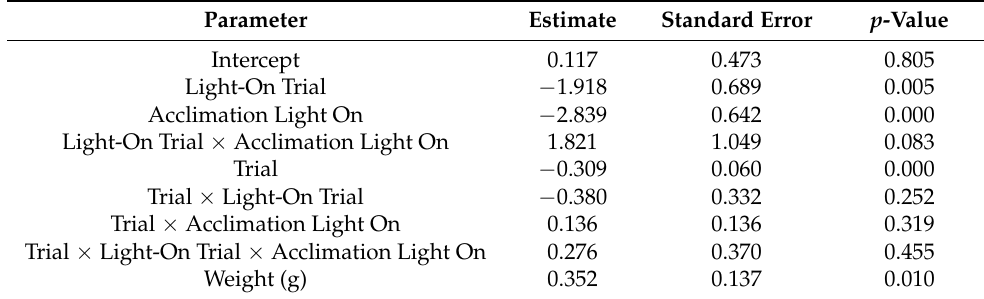
Table 1. Experiment 1 Startle Probability Regression